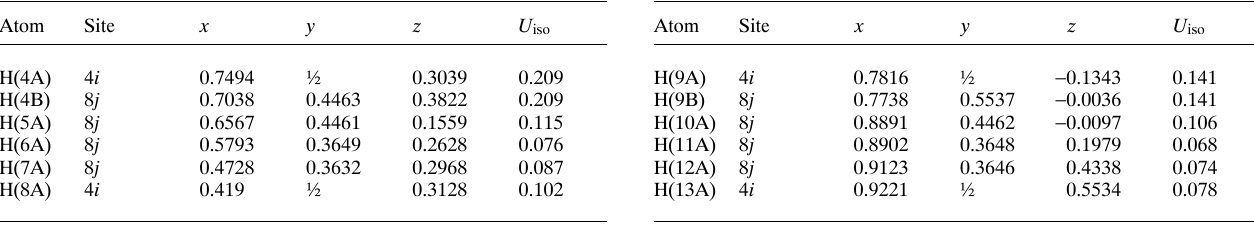
Table 2. A tomic coordin a tes a nd displ a cement p a r a meters (in Å 2 ) . Table 2. C ontinued